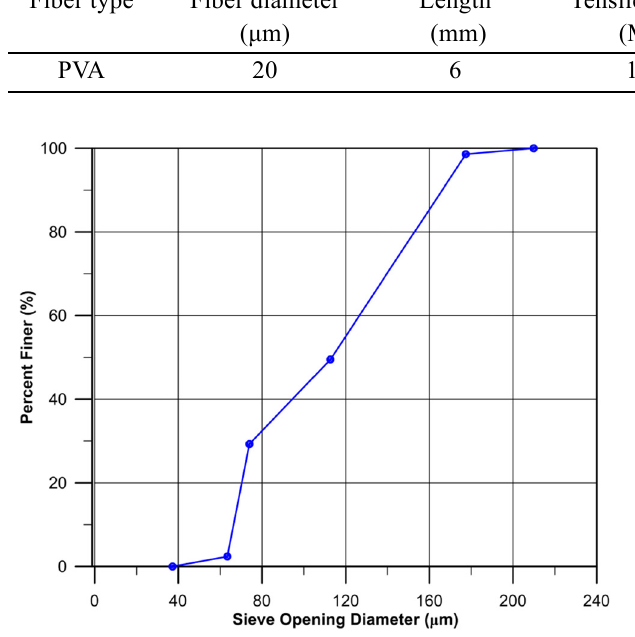
Fig.1. Cumulative particle size distribution of the sand